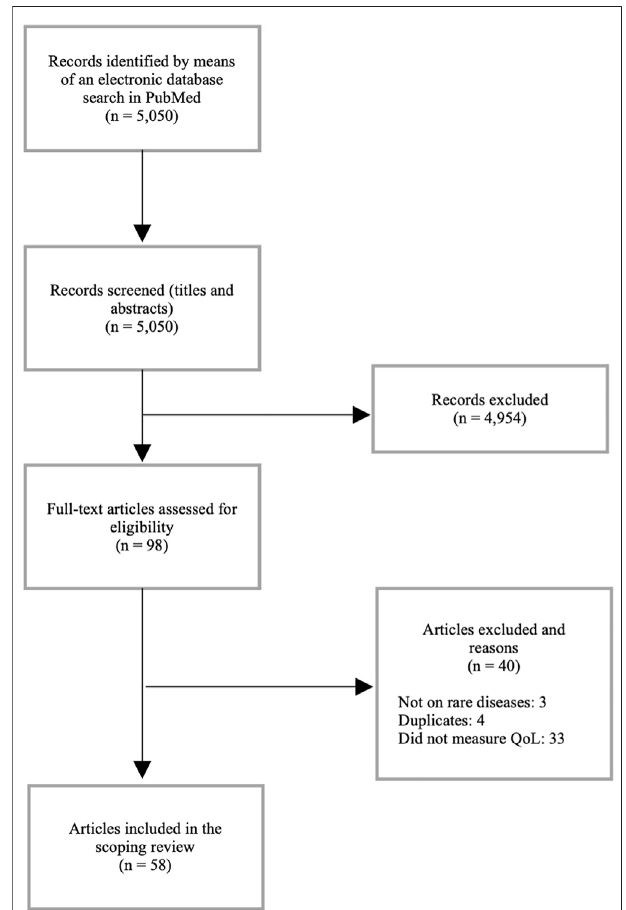
FIGURE 1 | Flow diagram of study